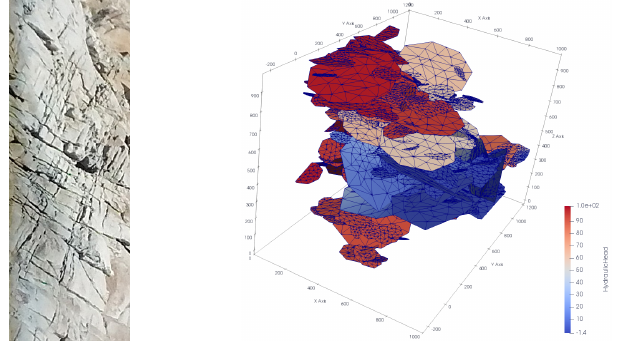
Figure 1. External surface of a natural fractured medium ( left ) and a Discrete Fracture Network (DFN) ( right